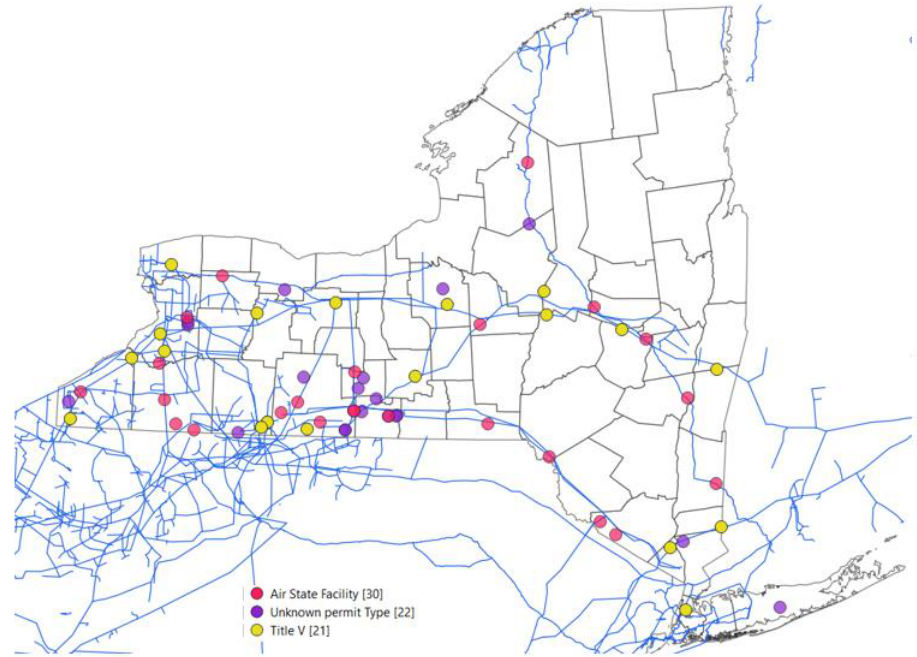
Figure 1. Natural gas pipelines across New York State (blue lines) and associated compression stations. Compressor stations are indicated by colored circles, indicating different types of permit. The black lines represent county and state boundaries.